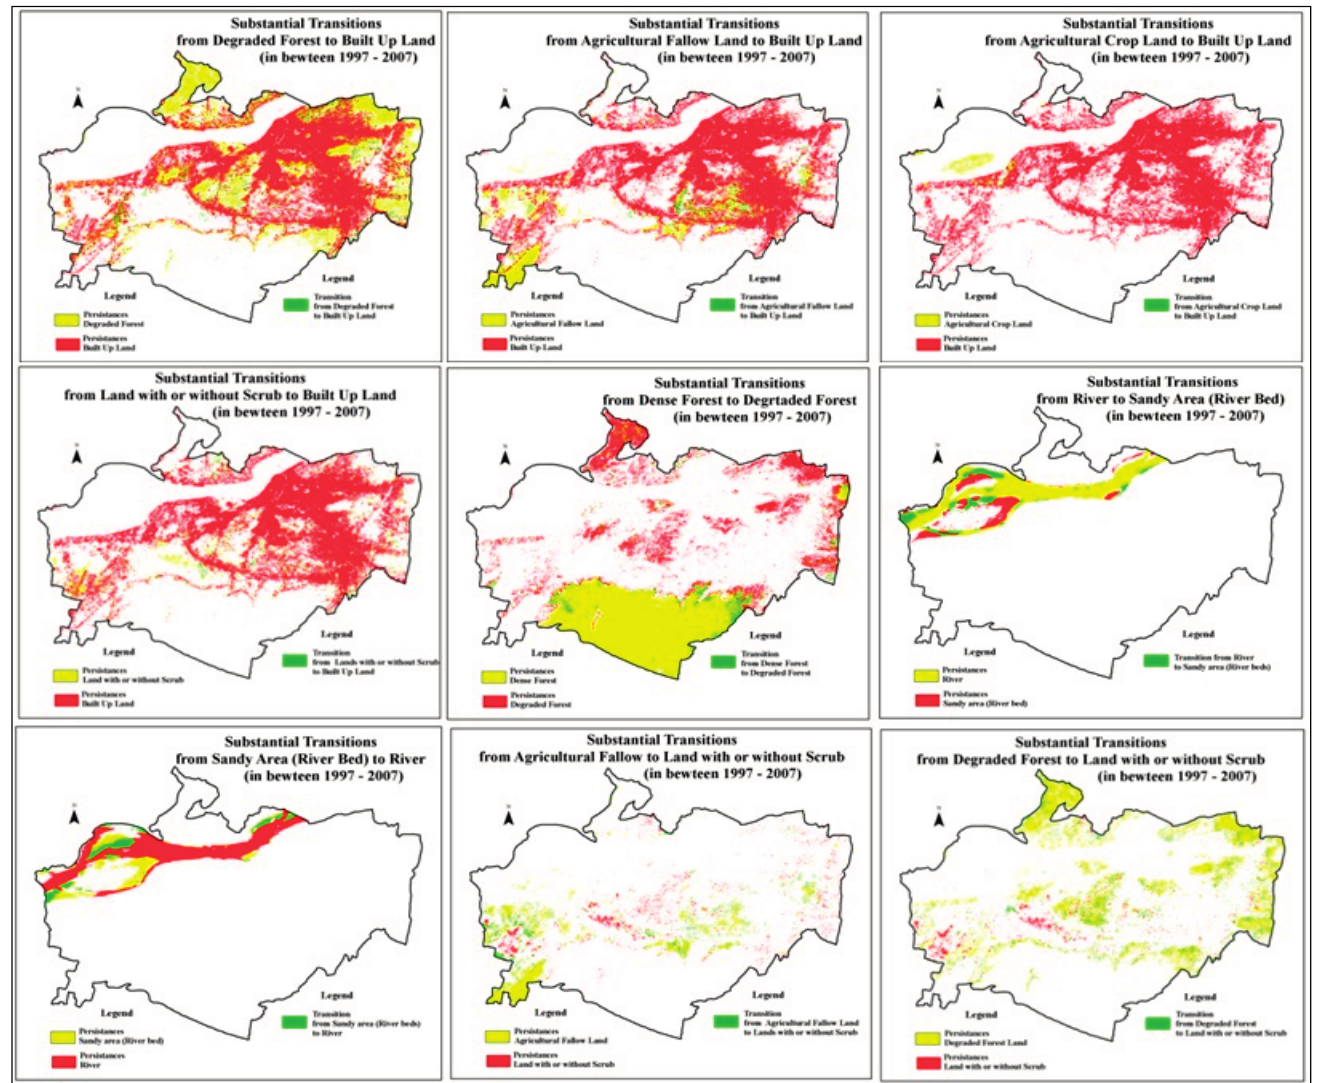
Figure 18. Substantial transitions between different LULC during